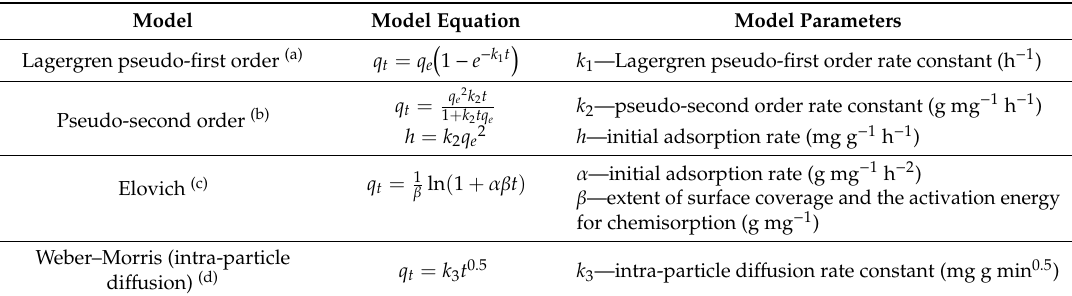
Table 1. Adsorption kinetics